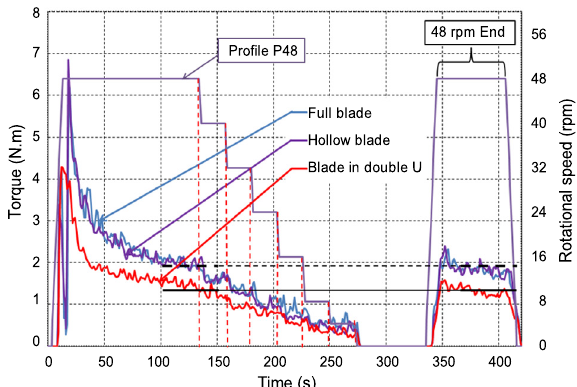
Fig. 12. B2 concrete’s measurements with the three blades